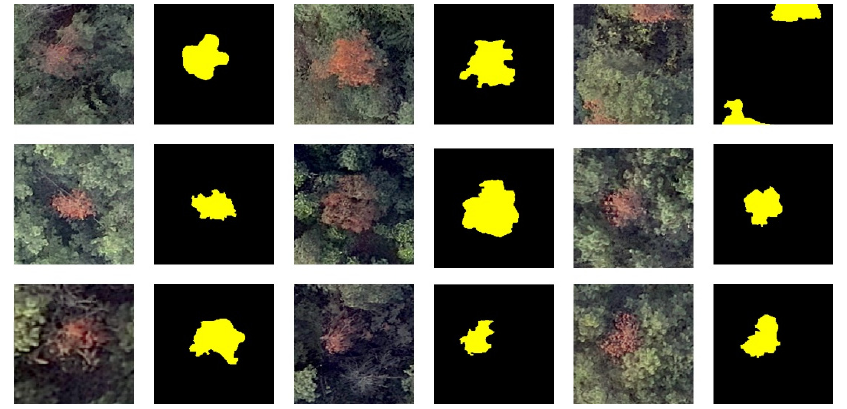
Figure 4. Sample database.